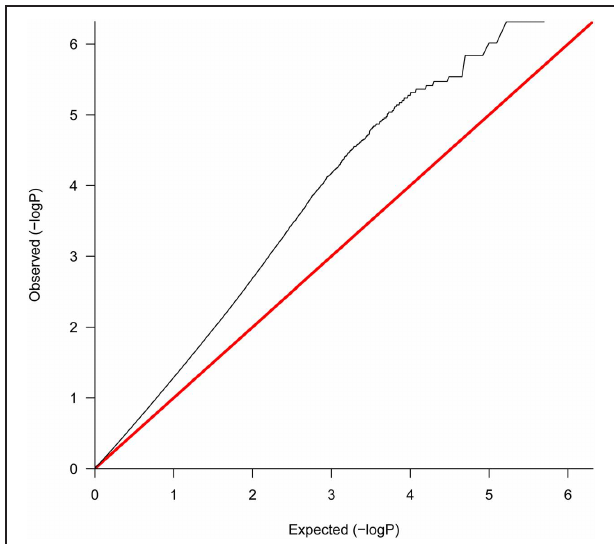
FIGURE 3 | Uniform Q-Q plot for gene expression of all contrasts across 4–42DPI after correcting for 0DPI estimated effect. This plot represents the quantiles of the empirical distribution of p -values vs. the expected quantiles of uniformly distributed p -values (corresponding to the null hypothesis). The represented departure from the straight line y = x indicates an excess of small p -values as compared to the expectation under the null hypothesis, consistent with the alternative hypothesis of differential expression.